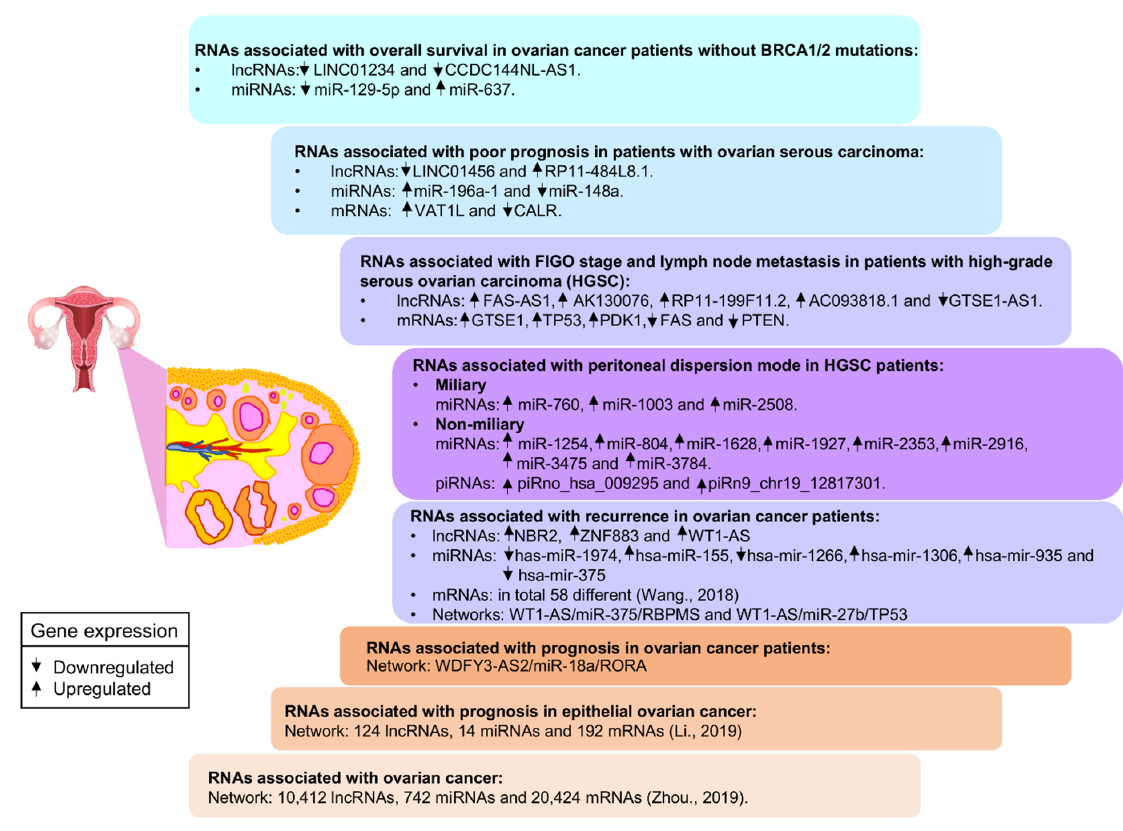
Figure 4. Use of coregulatory networks for the identification of ncRNAs-based clinical predictors. The analysis of the coregulatory networks allows identifying specific expression profiles of different RNA species for a given condition, and serving as clinical predictors, such as diagnosis, prognosis, recurrence, and survival of patients with cancer. Importantly, the modulation of identified lncRNAs may represent a valuable strat- egy for ovarian cancer treatment. The presence of dysregulated lncRNAs in EV circulating in serum also suggests that they may serve as biomarkers for early drug resistance pre- diction without invasion procedures, allowing a rapid switch in therapeutic strategy to improve patient survival. However, these studies have some limitations. Even if dysreg- ulation of several lncRNAs is confirmed in ovarian tumors, the elucidation of the lncRNAs/miRNAs/mRNAs axis involved in chemoresistance is mostly demonstrated in vitro, and there are no validation studies in samples from drug resistant patients. Moreo- ver, most studies only focused on one drug, therefore it would be of interest to verify whether the identified lncRNAs/microRNAs coregulation networks also control re- sistance to other drugs. In conclusion, all the individual lncRNAs/microRNAs pairs and interaction networks described here may represent potential therapeutic targets for clini- cal intervention. Author Contributions: C.L.-C., D.G.-R., and E.R.-G. conceived and designed the review; C.L.-C., D.G.-R., E.R.-G., Y.M.S.-V., M.B.S.-C., O.N.H.-d.l.C., and L.A.M. performed the literature review and were involved in the writing and revision of the manuscript; Y.M.S.-V. and O.N.H.-d.l.C. prepared all the figures. All authors have read and agreed to the published version of the manuscript. Funding: This research was partially funded by the Consejo Nacional de Ciencia y Tecnologia CONACyT, México (A1-S-13565 grant). Institutional Review Board Statement: Not applicable. Informed Consent Statement: Not applicable.